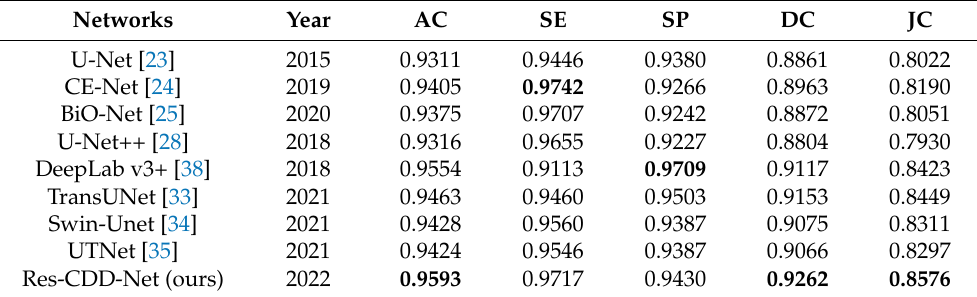
Table 7. Testing results of our Res-CDD-Net and other mainstream networks on the PH2 dataset.